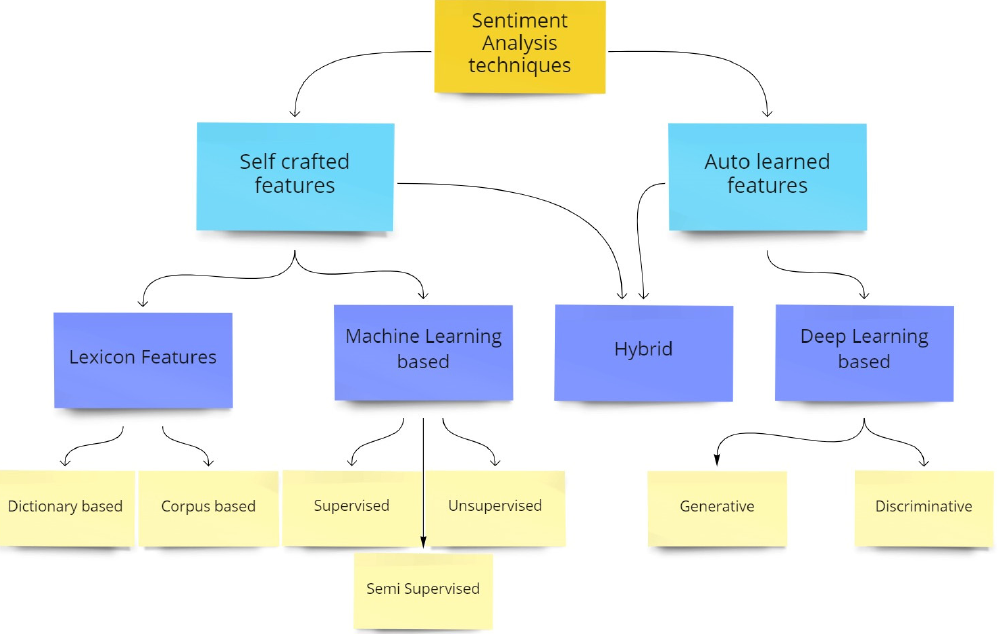
Figure 1. Sentiment Analysis